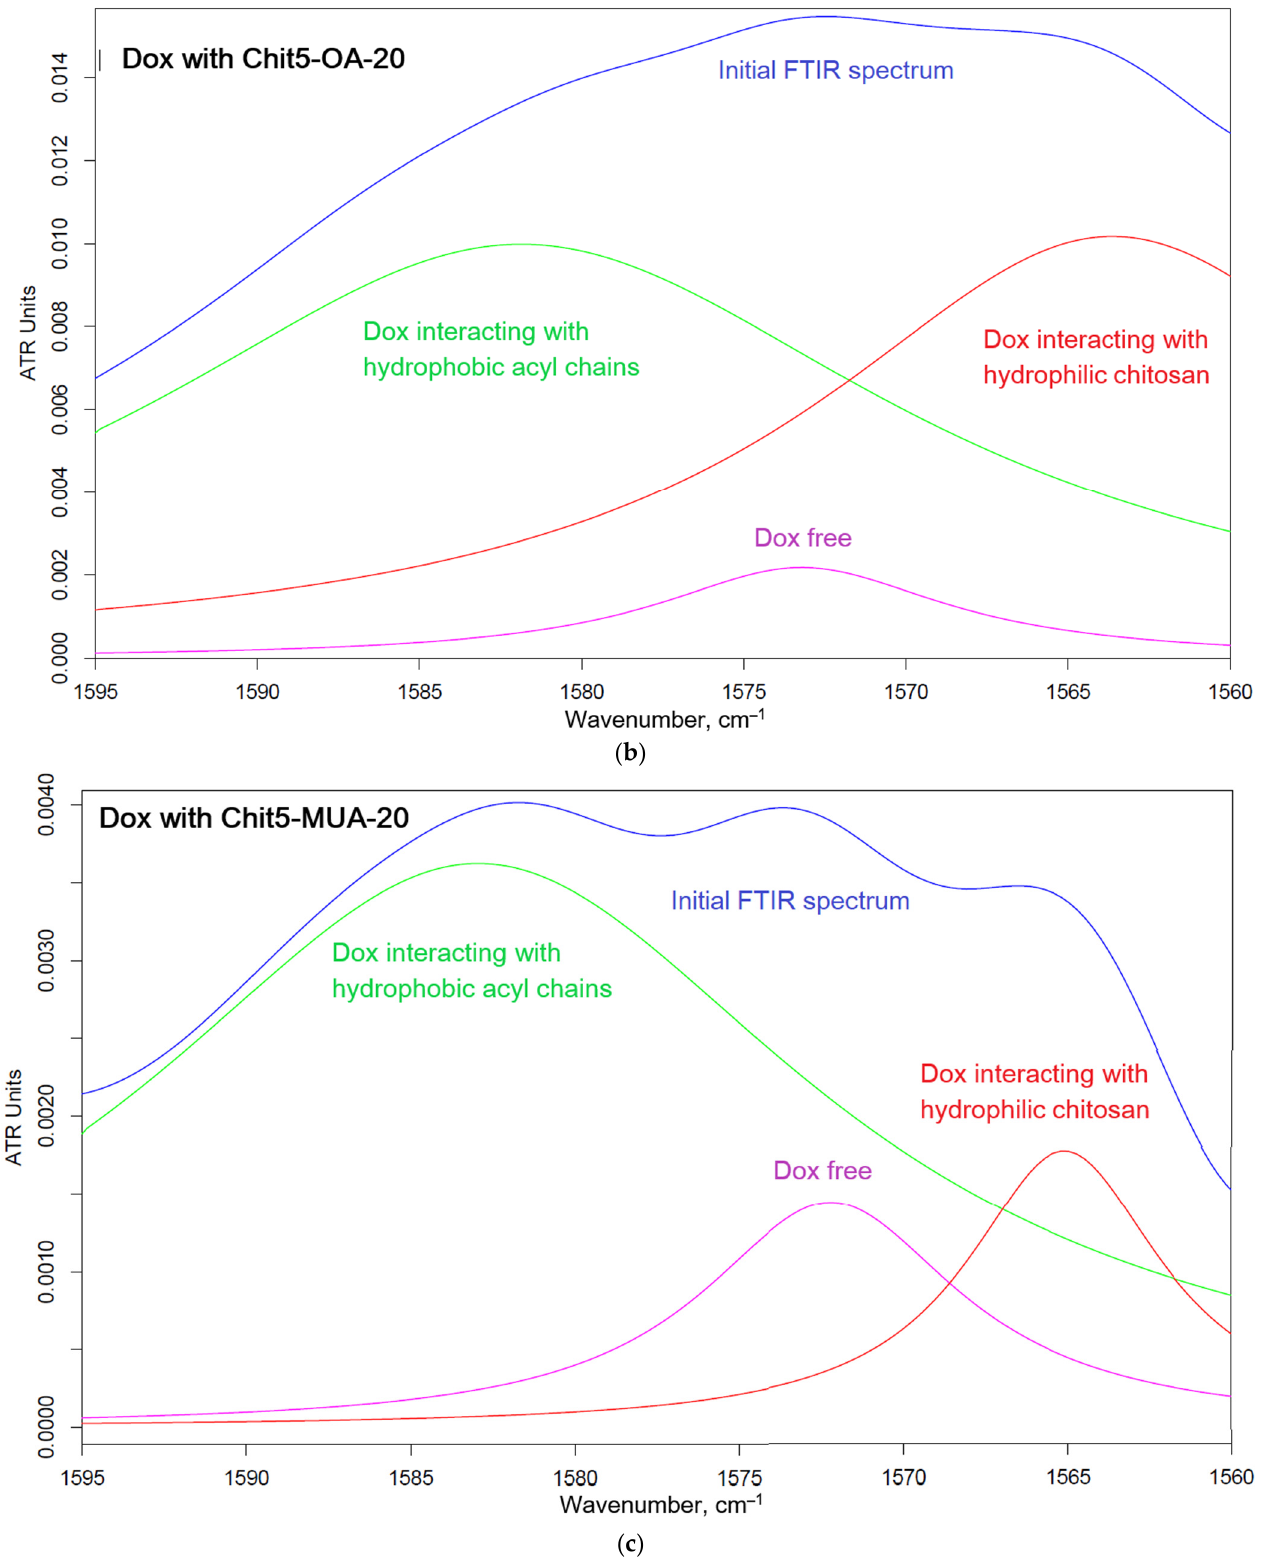
Figure 5. Doxorubicin FTIR spectra («aromatic» region) deconvolution with Lorentzians: ( a ) in free form, ( b ) loaded into Chit5-OA-20 micelles at pH = 5.5 (sodium acetate buffer, 0.01 M), and ( c ) loaded into Chit5-MUA-20 micelles at pH = 7.4 (PBS, 0.01 M). T = 37 °C.